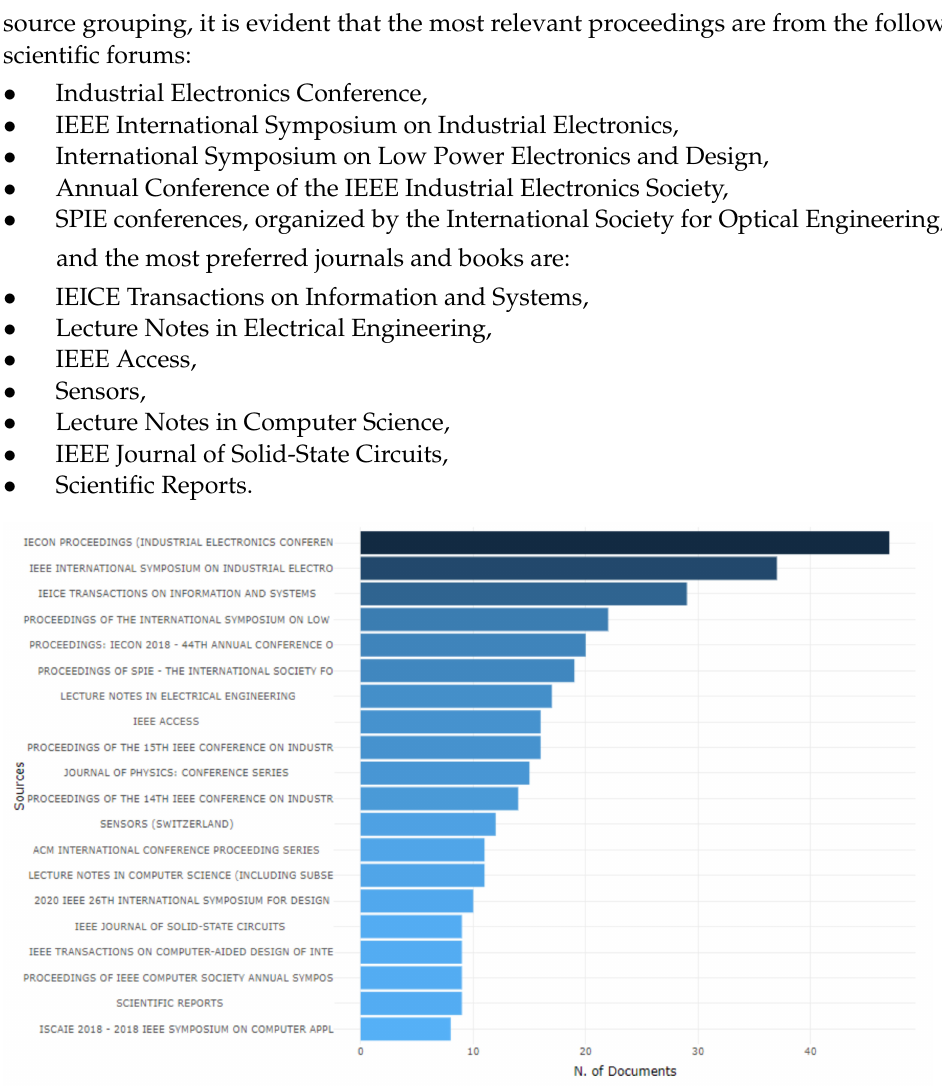
Figure 5. The most relevant sources according to